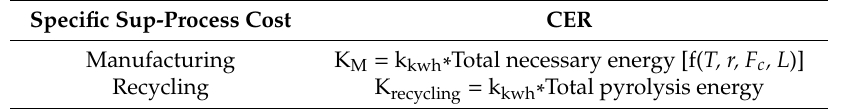
Table 6. Cost Estimation relationships (CERs) for manufacturing and recycling cost.